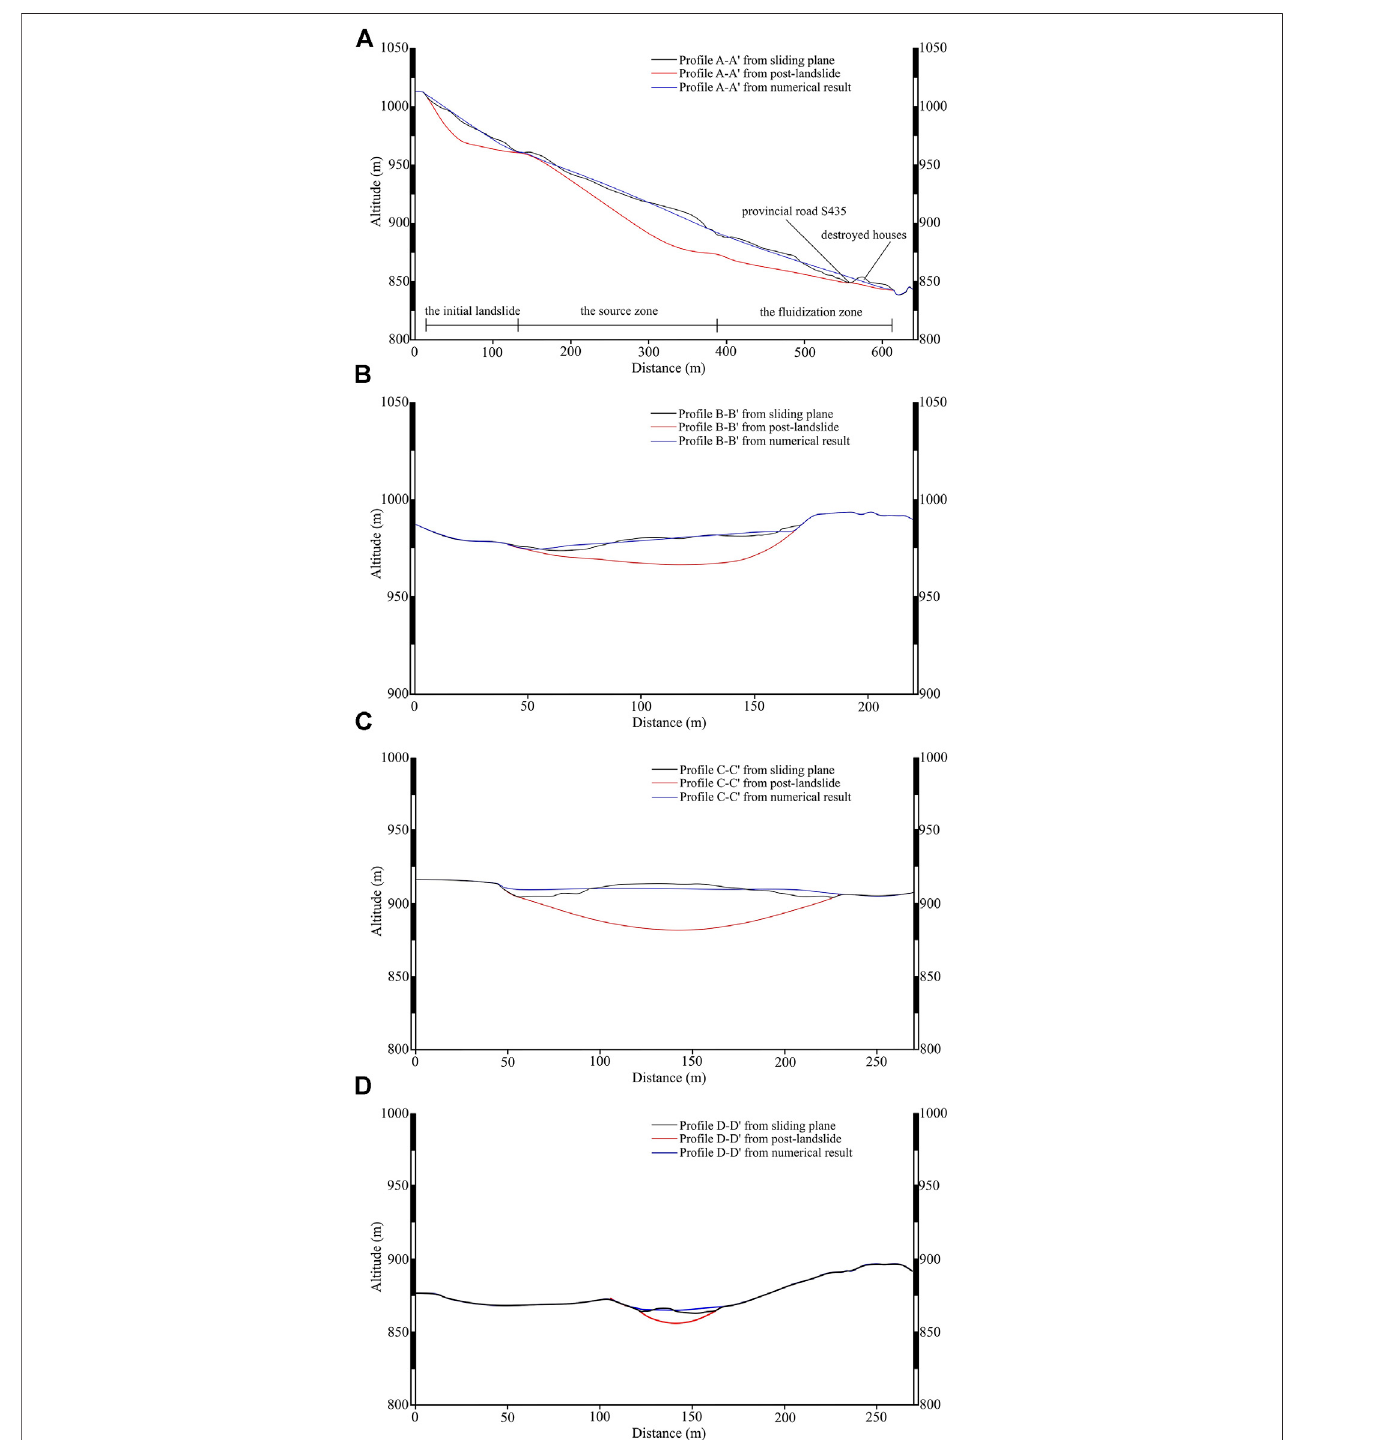
FIGURE 10 | Comparison of the numerical results and fi eld investigations along (A) the main sliding pro fi le A-A ’ , (B) the transverse pro fi le B-B ’ , (C) the transverse pro fi le C-C ’ , and (D) the transverse pro fi le D-D ’ .